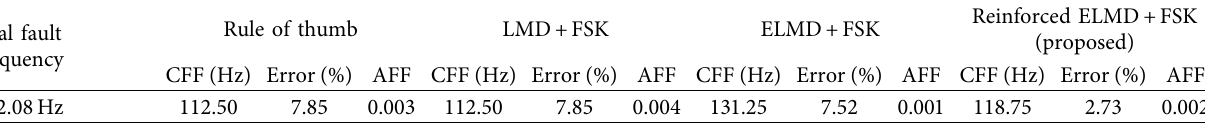
Reinforced ELMD +FSK (proposed)